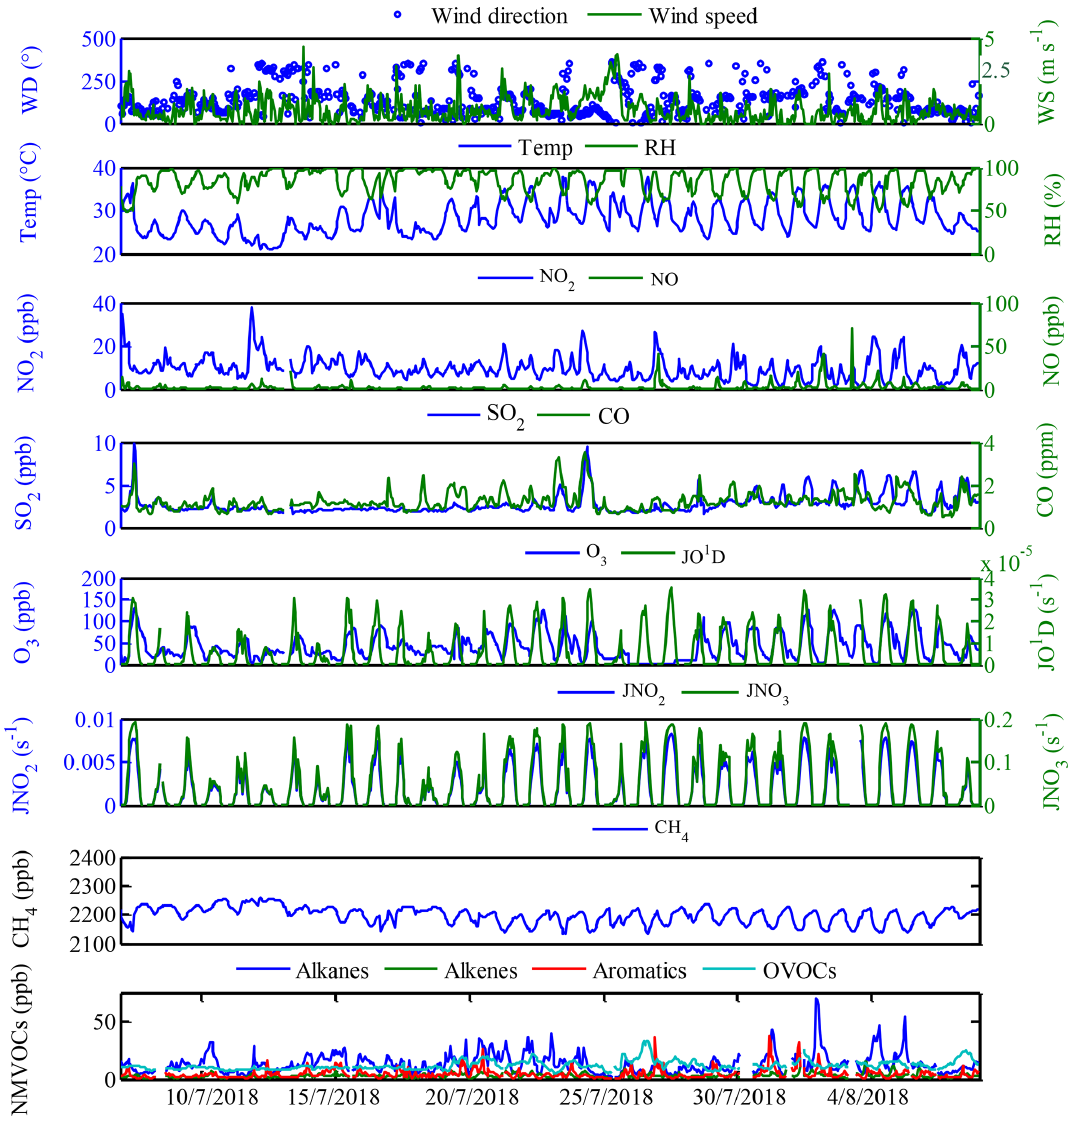
Figure 2. Time series of meteorology parameters, trace gases, photolysis rates and VOC concentrations during the field campaign at Xianghe from 6 July to 6 August